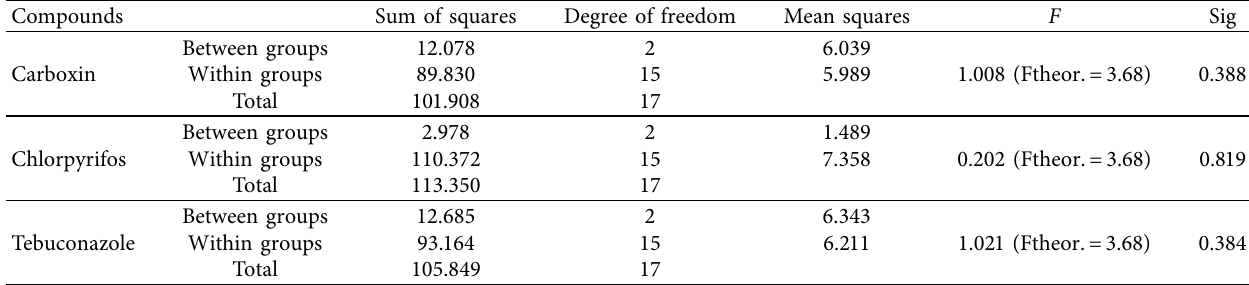
Table 4: One-way ANOVA statistical analysis results of carboxin, chlorpyrifos, and tebuconazole in cabbage samples obtained by applying DDRSD, SDRS, and MCRS methods.